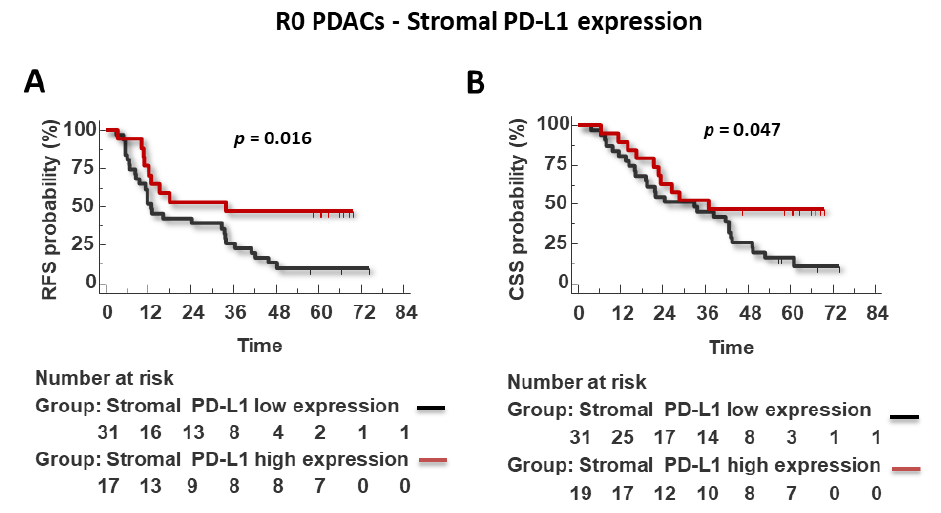
Figure 7. Stromal lympho-monocytic PD-L1 high expression predicts improved RFS and CSS survival in R0 patients. Survival LogRank analysis correlates with recurrence-free survival (RFS) ( A ) and cancer-specific survival (CSS) (months) ( B ). 3.6. Tumoral CXCL12 Is an Independent Poor Prognostic Factor at the Multivariate Analysis In multivariate analysis (Table 5), the pathological AJCC Stage 8th ed. ( p = 0.049), perineural invasion ( p = 0.0107), and CXCL12 ( p = 0.00002) but not CXCR4, predicted shorter poor RFS (Table 5 left). The pathological AJCC Stage 8th ed. ( p = 0.00007), vascular invasion ( p = 0.0067), and CXCL12 ( p = 0.0062) but not CXCR7 nor CXCR4 expression pre- dicted shorter poor CSS (Table 5 right); thus, CXCR7 or CXCR4 were not retained in the final multivariate models of RFS and CSS. Table 5. Multivariate analysis of cancer specific survival and recurrence-free survival: Cox proportional-haz- ards regression.